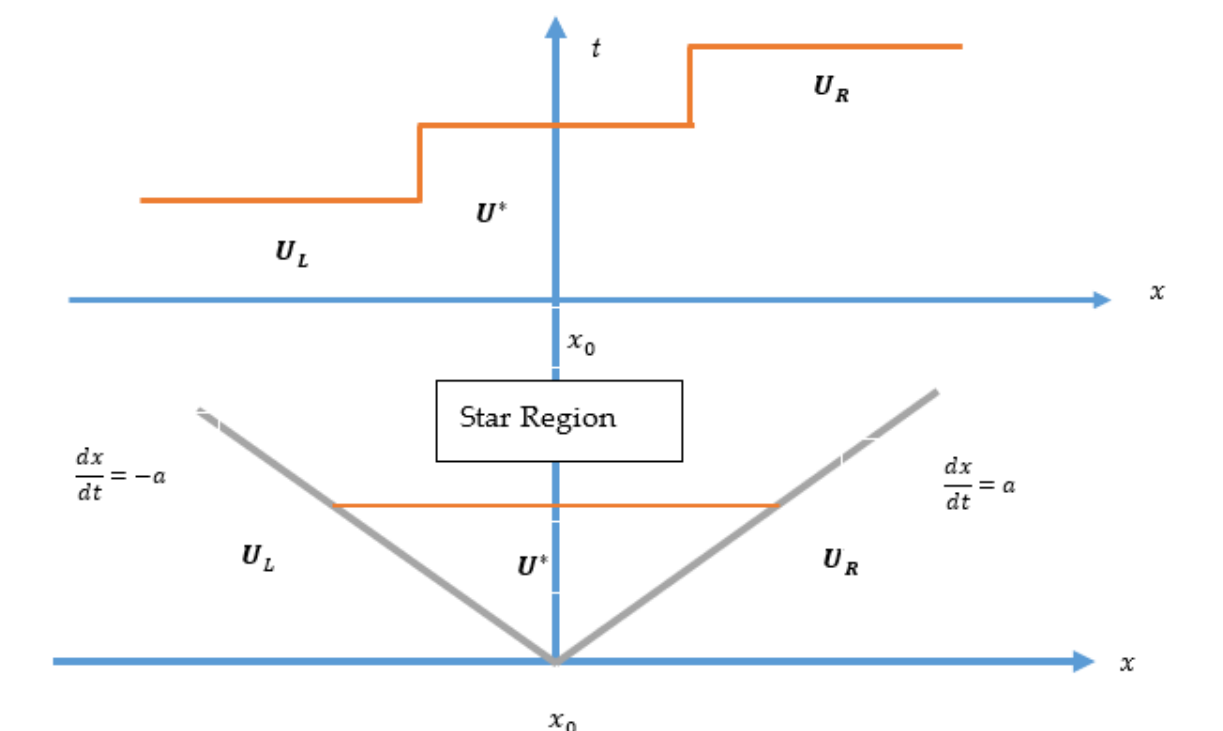
Figure 5. Solution of the Riemann problem in the physical space (top) and in the phase space (bottom) [9].